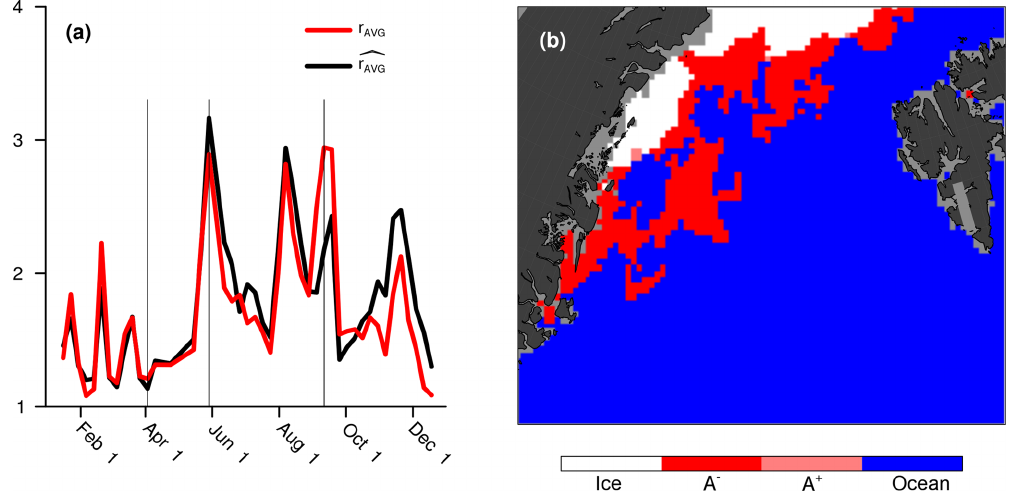
Figure 9. (a) Time series of two metrics ratios for forecasts with a lead time of 5d. Vertical lines correspond to cases for which results are discussed in detail. The left and centre vertical lines correspond to the two forecasts that were analysed in Sect. 4, whereas the line to the right is for the situation displayed in panel (b) . (b) Detail of IIEE in the Fram Strait (the region between Greenland and the Svalbard